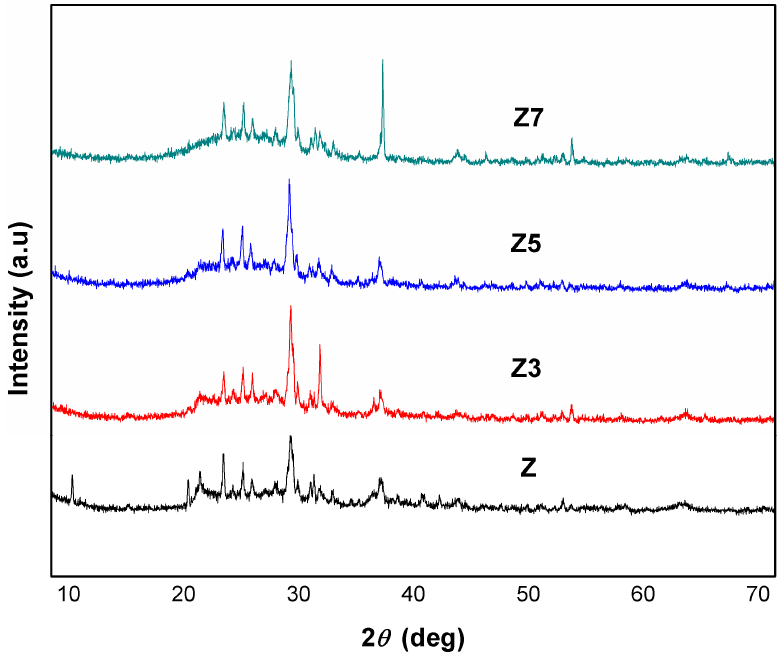
Figure 6. XRD diffractogram comparison of Z, Z3, Z5, and Z7.